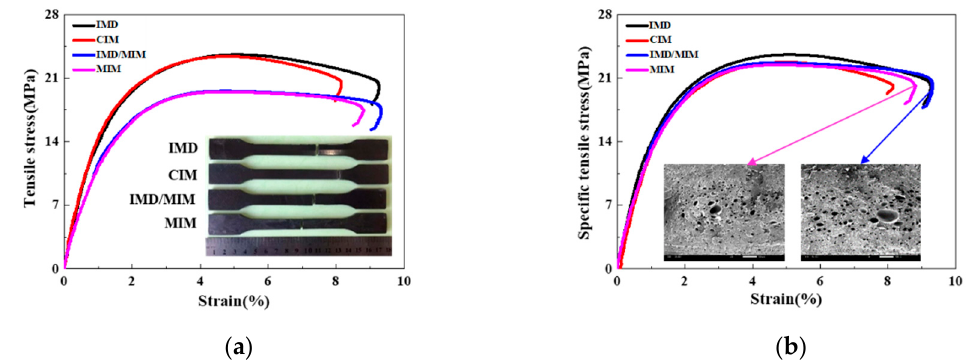
Figure 7. The tensile properties of the IMD, CIM, IMD/MIM and MIM samples: ( a ) tensile stress-strain curves; ( b ) specific tensile stress-strain curves.